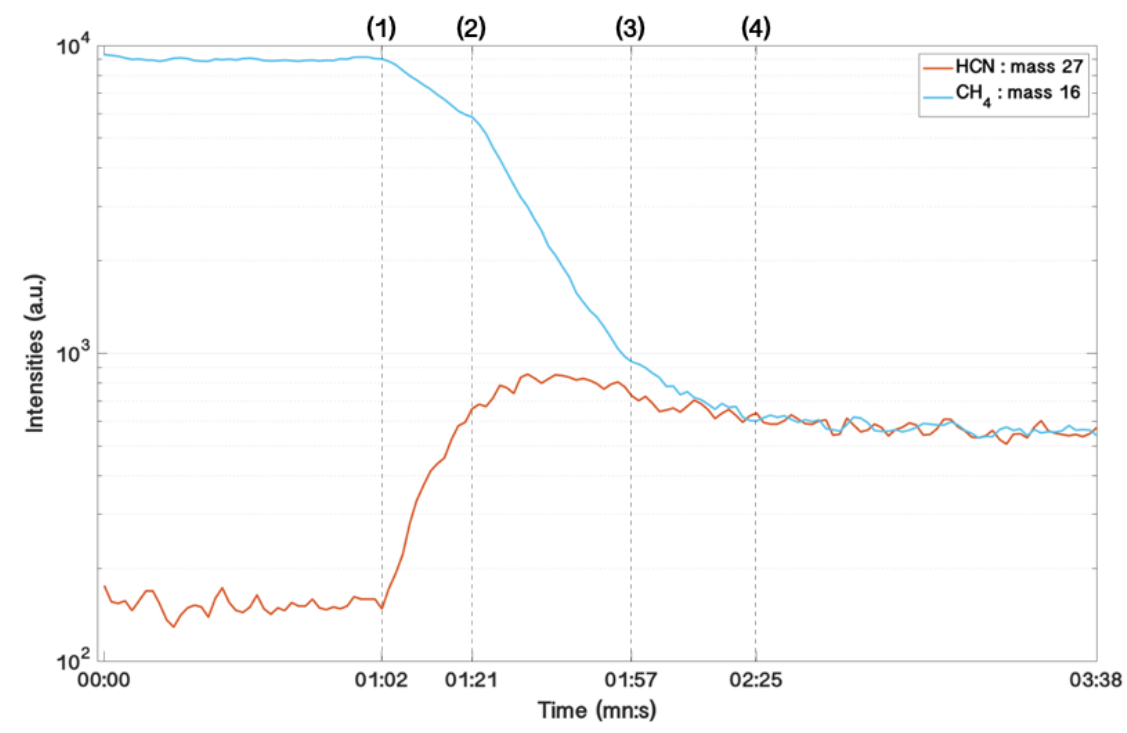
Figure 4. Time evolution of the masses m/z 16 (CH 4 ), 27 (HCN), obtained with a mass spectrometer. These species are formed from an initial gas mixture of N 2 –CH 4 injected in the PAMPRE reactor. (1) At one minute, a plasma discharge is triggered, ionizes the injected gas mixture, and dissociates, in particular, the methane (first slope of decrease CH 4 ). (2) Apparition of primary monomers in the plasma (second decay slope of CH 4 ). Between (2) and (3), the primary monomers grow spherically down to a few hundred nanometres. (3) Formation of aggregates of primary monomers (third decay slope of CH 4 ). Between (3) and (4): The aggregates evolve into micrometric monomers. After (4), the formed tholins exit the plasma and sediment at the bottom of the reactor.